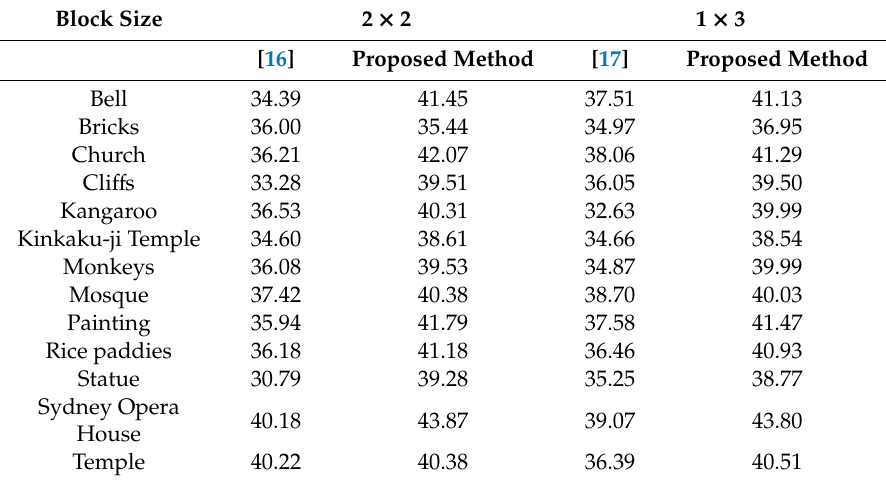
Table 4. PSNRs of Imaizumi et al.’s [16], Aryal et al.’s [17], and the proposed methods with a capacity 45,000 bits and k =